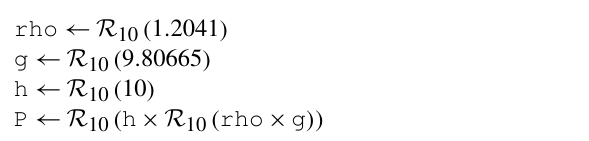
Algorithm 1 Operations performed by the reduced-precision program (Fig.